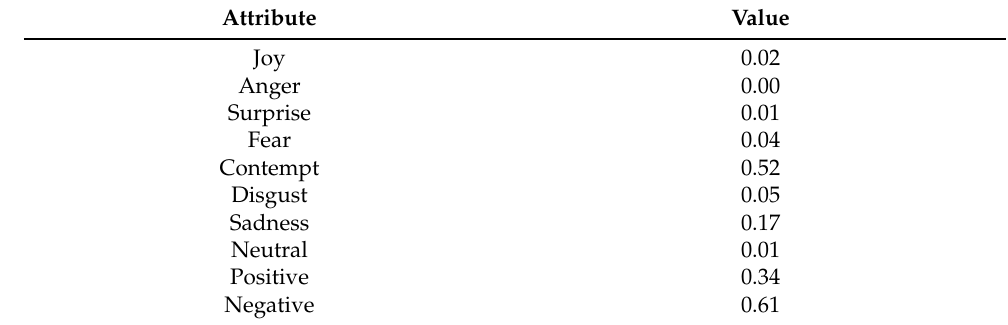
Table 11. p -values of the percentage of observable time for each emotion of H a 2 . Note: p -values were truncated to two decimal